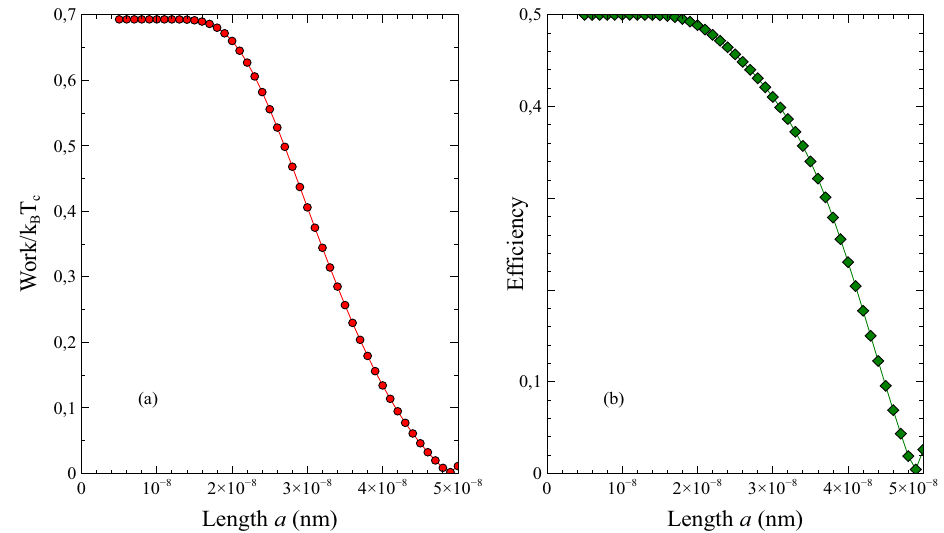
Figure 2. ( a ) Work, ( b ) Efficiency versus length a (nm) for the non-fractional quantum heat engine. Here, we have set the constants as m K and T c